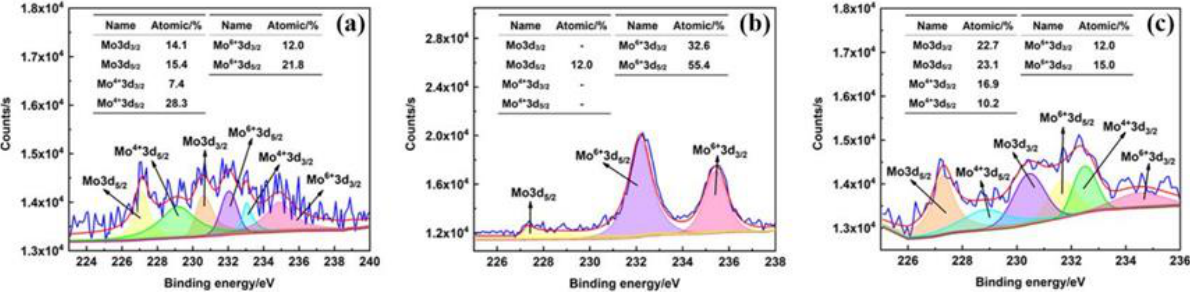
Figure 12. Mo2p peak fitting of 2205 DSS cladding layer under different current. ( a ) 90 A; ( b ) 100 A; ( c ) 110 A.